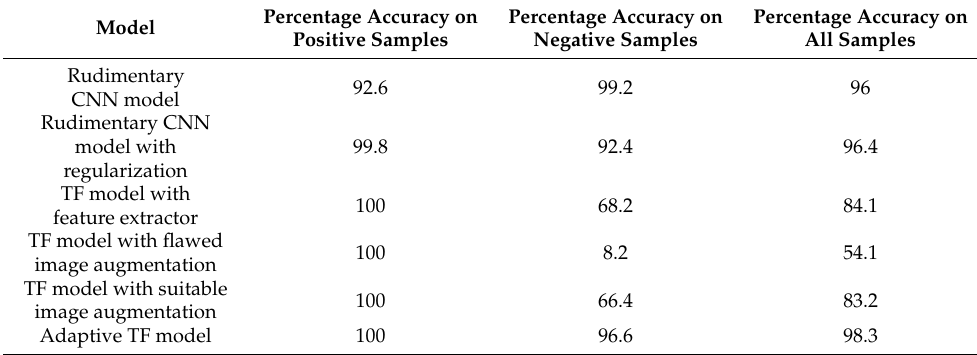
Table 2. Classification results on the models proposed.